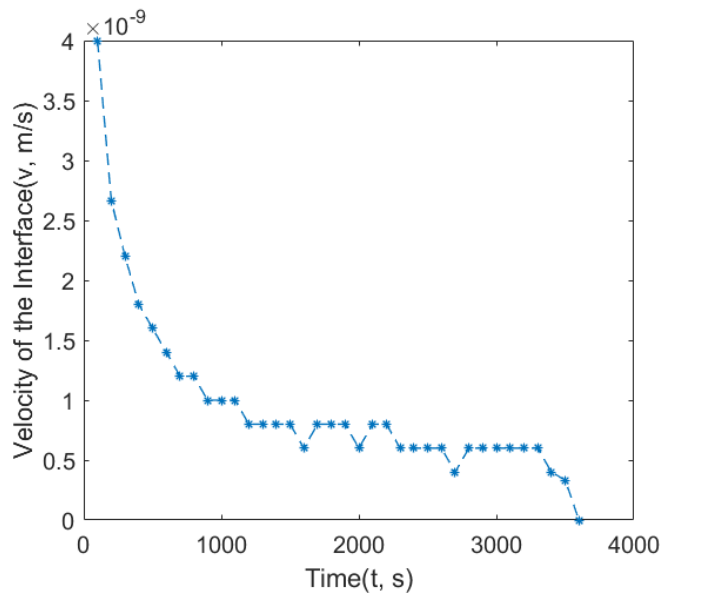
Figure 8. Velocity of the interface for SL 3 setup where the velocity is observed to drop with